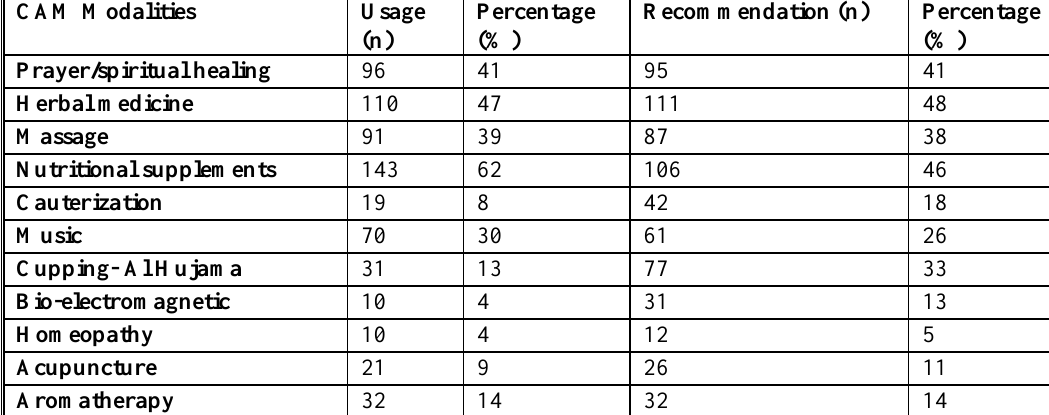
Table 2.The usage and recommendation behaviors of CAM among pharmacists. (N=